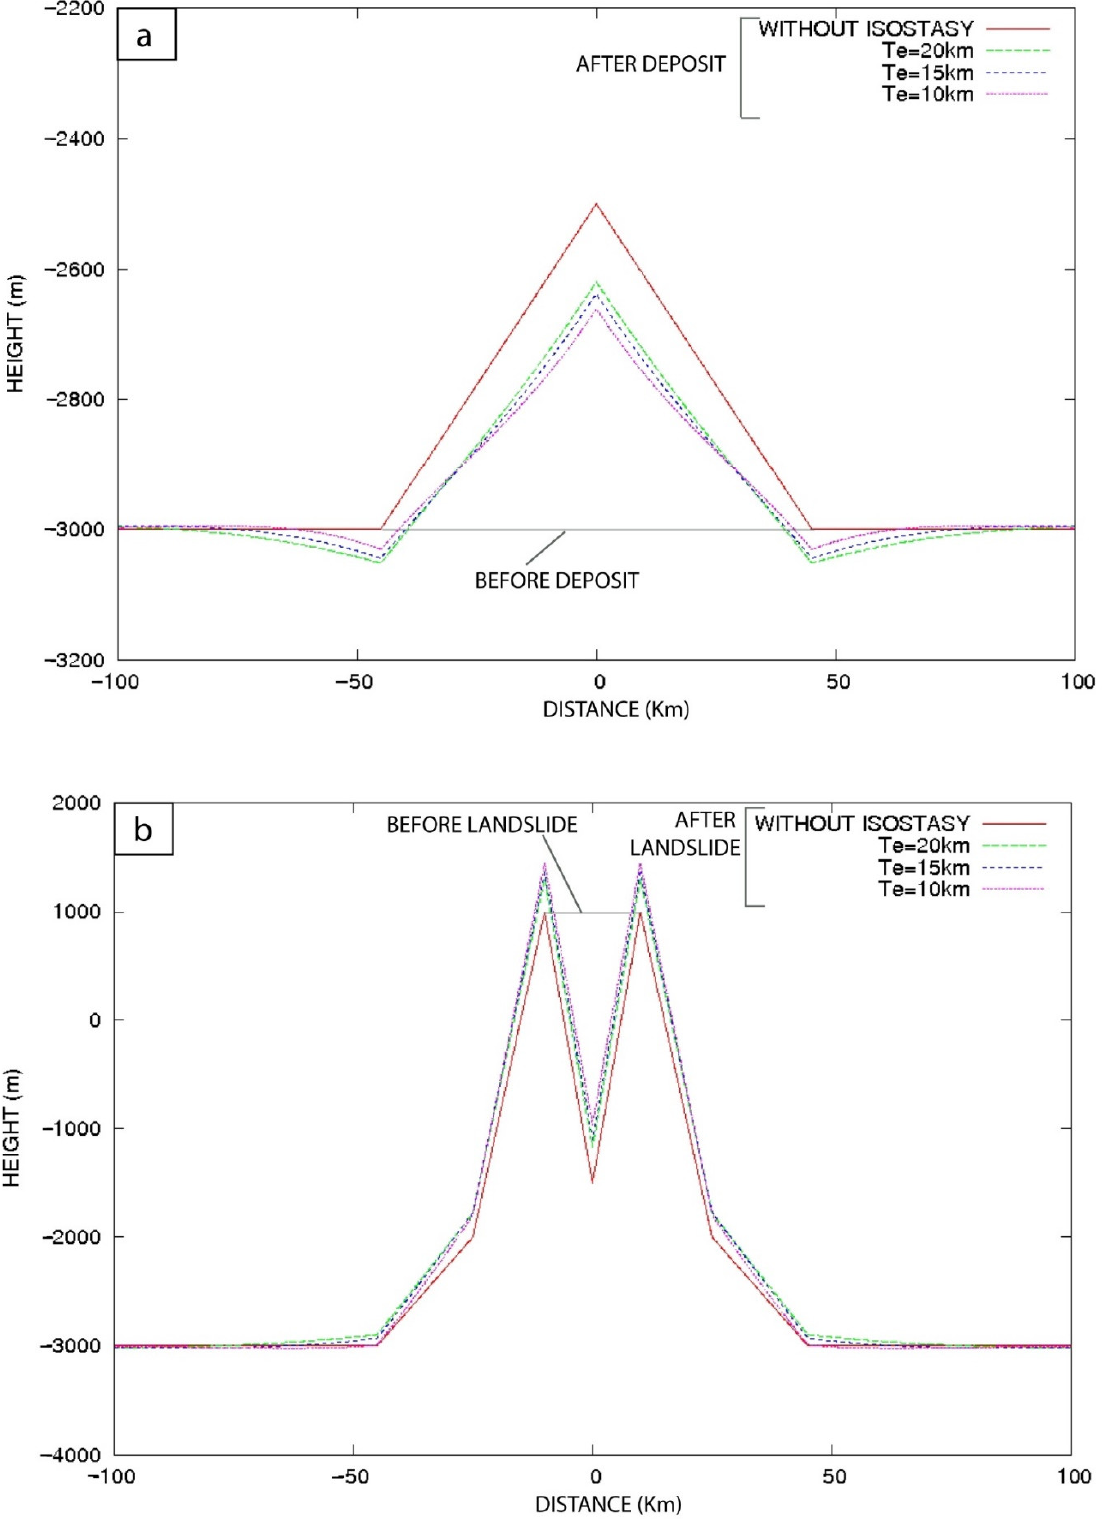
Figure 7. Modeling of the isostatic adjustment on the Tahiti volcano after a giant landslide ( a ) in the deposit area, ( b ) in the landslide scar area. These models are perpendicular to the previous ones presented in Figures 3–5. The position of these sections is shown in Figure 1a.